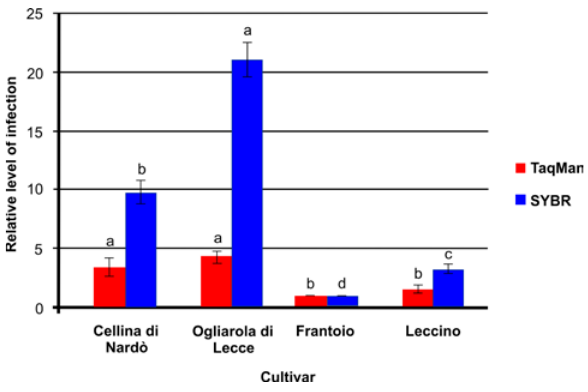
Figure 2. Relative levels of Xylella fastidiosa in four olive cultivars, expressed as fold changes (2 –ΔCt ) calculated us- ing the cultivar Frantoio as an arbitraryily chosen baseline and chalcone synthase as calibrator. Letters a, b, c and d in- dicate statistical groups that differ significantly ( P ≤